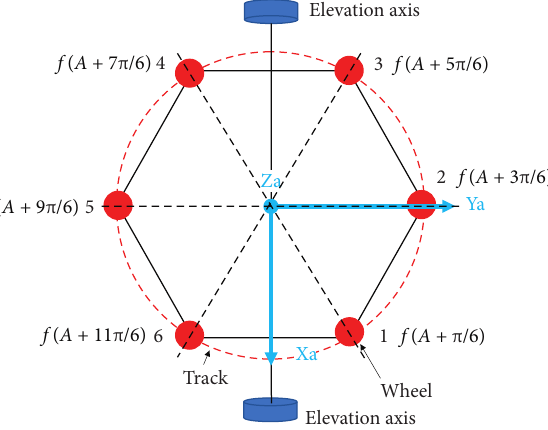
Figure 5: The sketch of the six support points telescope design.